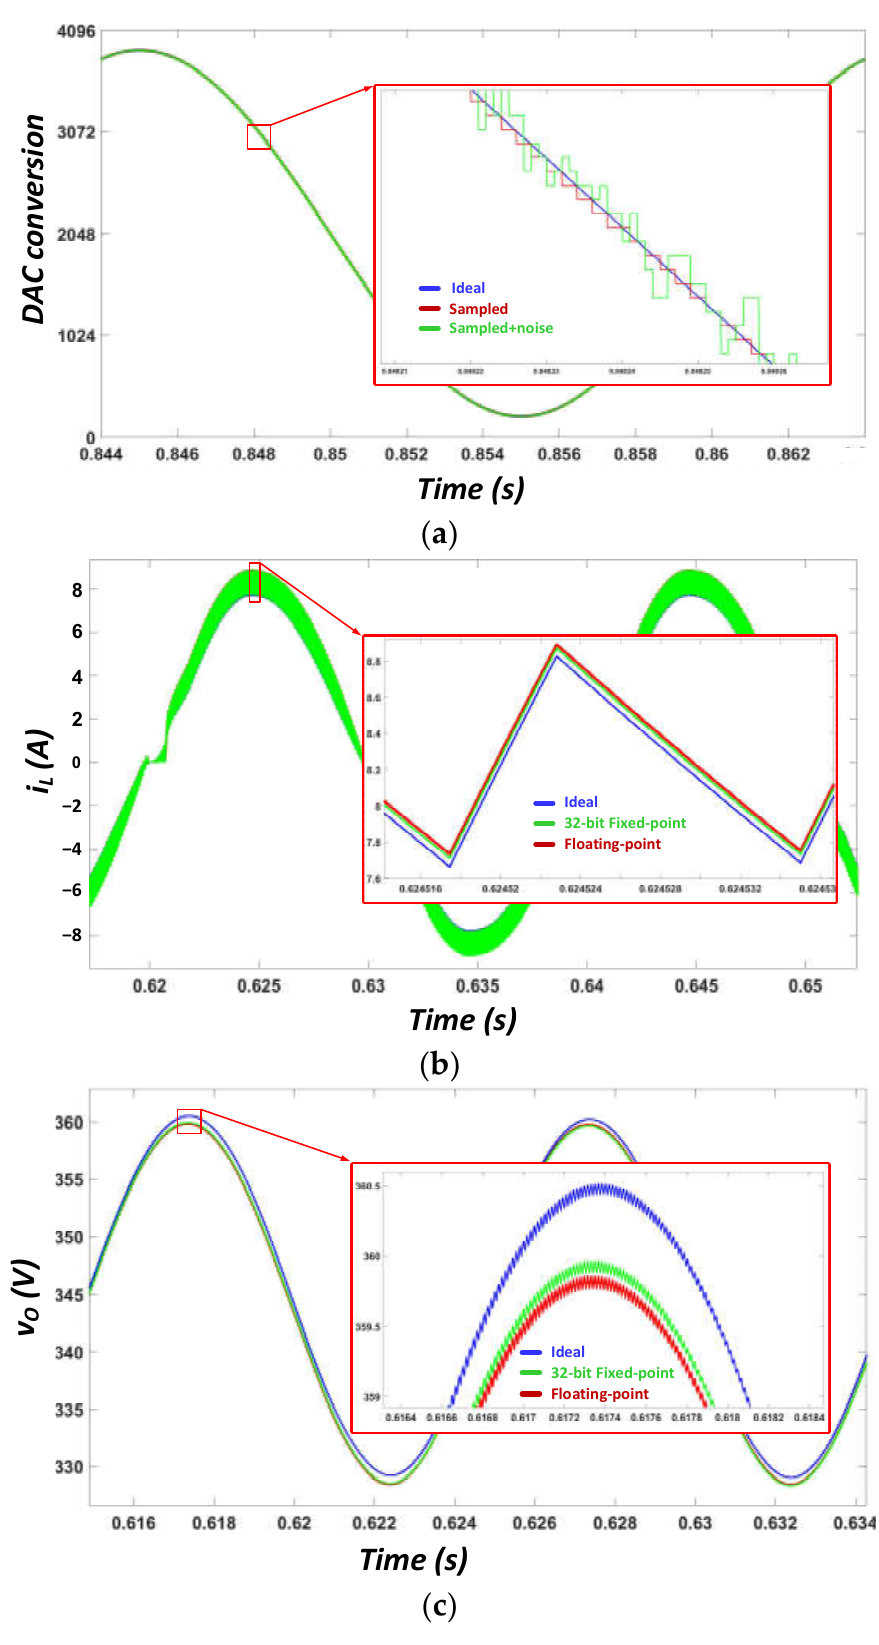
Figure 6. Simulated waveform in totem-pole. ( a ) grid voltage (input signal of the HIL after DAC conversion), ( b ) inductor current and ( c ) output voltage.